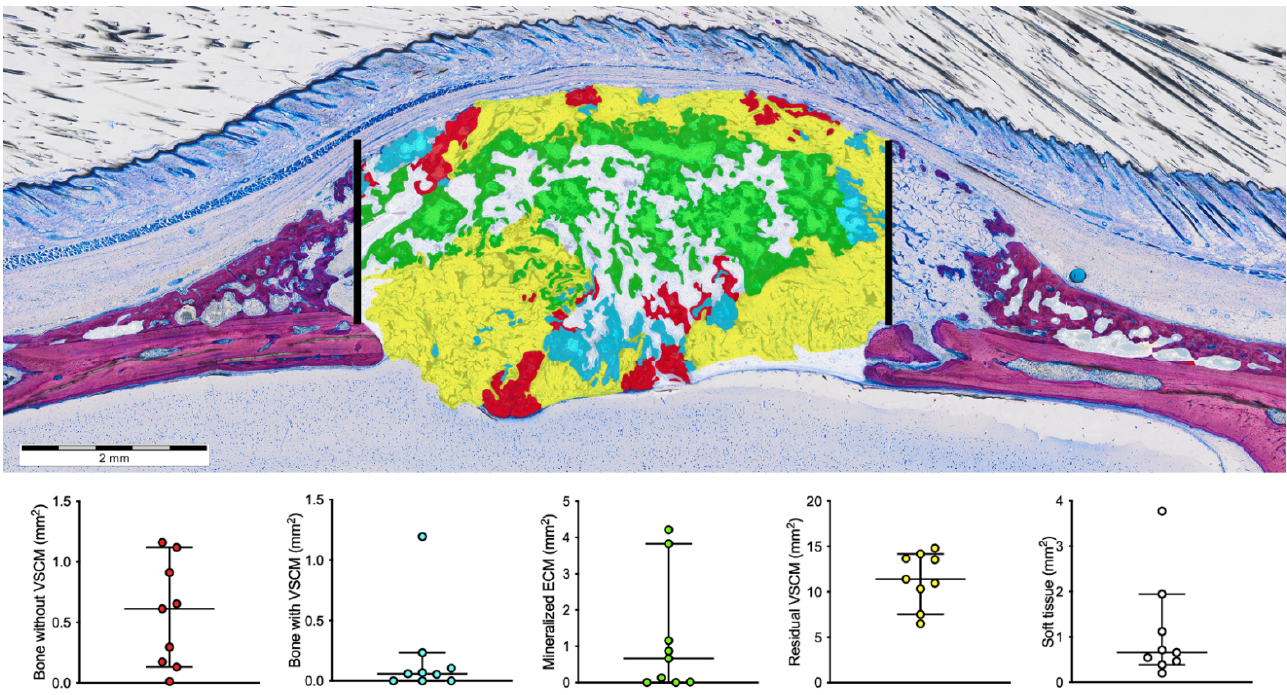
Figure 6. Histomorphometric analysis—strategy of segmentation and descriptive statistics. The segmentation was based on the characteristic features of tissues by high-resolution microscopy. Manual segmentation depicts the new bone alone without VSCM (red), the new bone entombing the VSCM (cyan), the extracellular matrix resembling mineralized cartilage (mineralized ECM; green), the VSCM alone (yellow), and the remaining soft tissue (white). The bars show the median and 95% confidence interval.